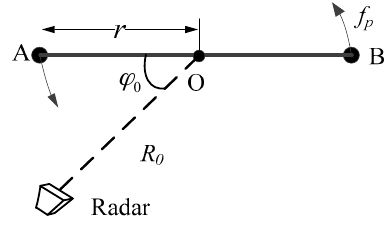
Figure 2. The typical rotating target structure.